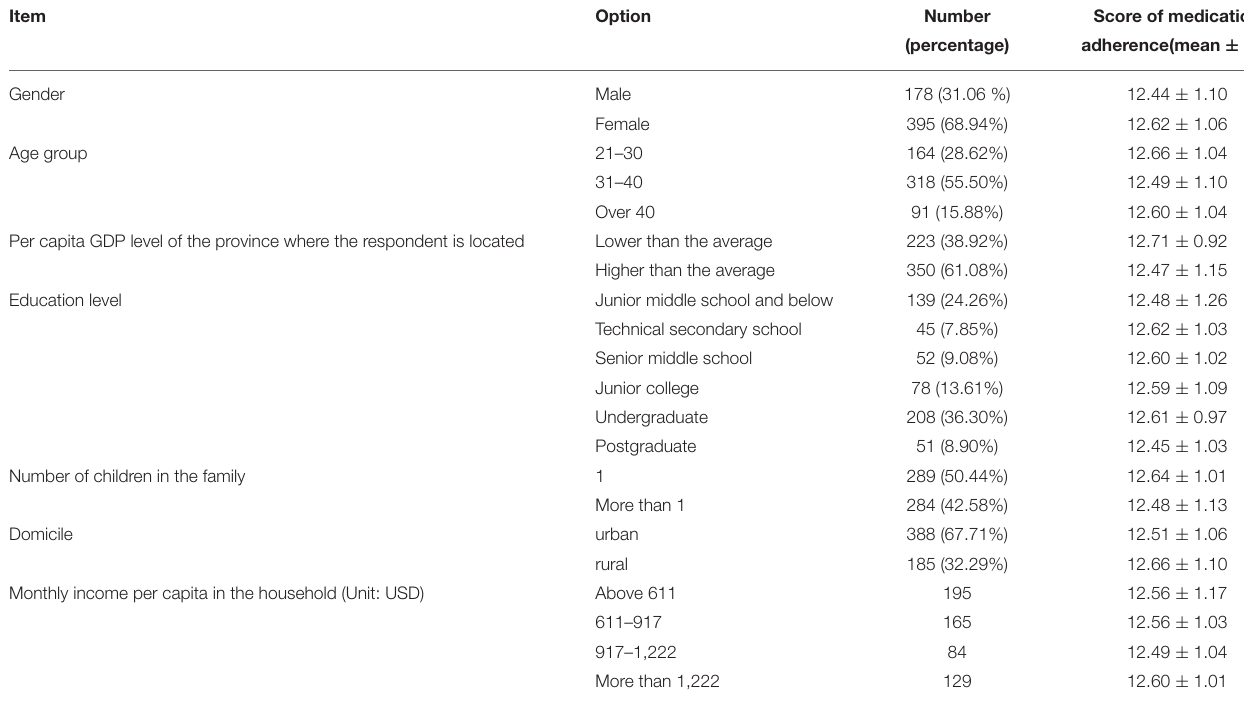
TABLE 2 | Demographic characteristics and score of children’s medication adherence of